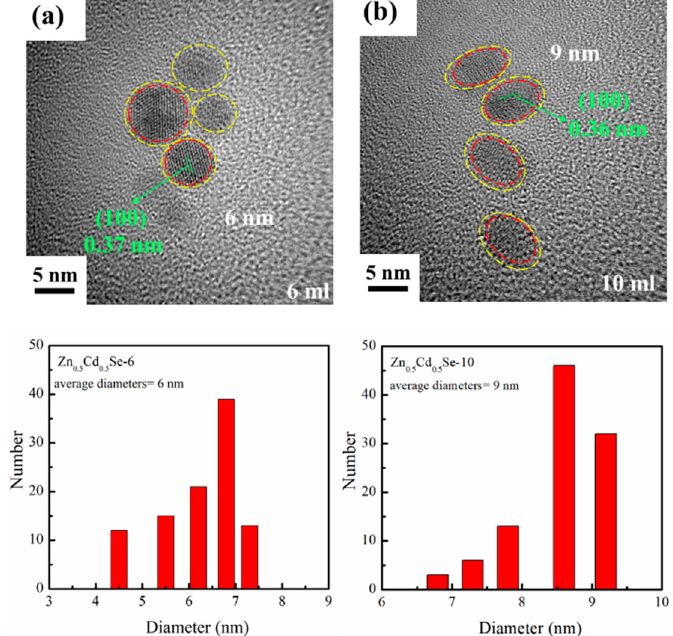
Figure 7. HRTEM images and size distributions showing the influence of the high OLA contents on the ( a ) Zn 0.5 Cd 0.5 Se-6 and ( b ) Zn 0.5 Cd 0.5 Se-10 alloy QDs.